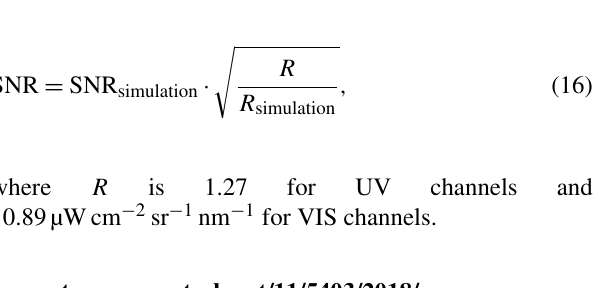
1.27/10.89 µW cm − 2 sr − 1 nm − 1 can be achieved by the